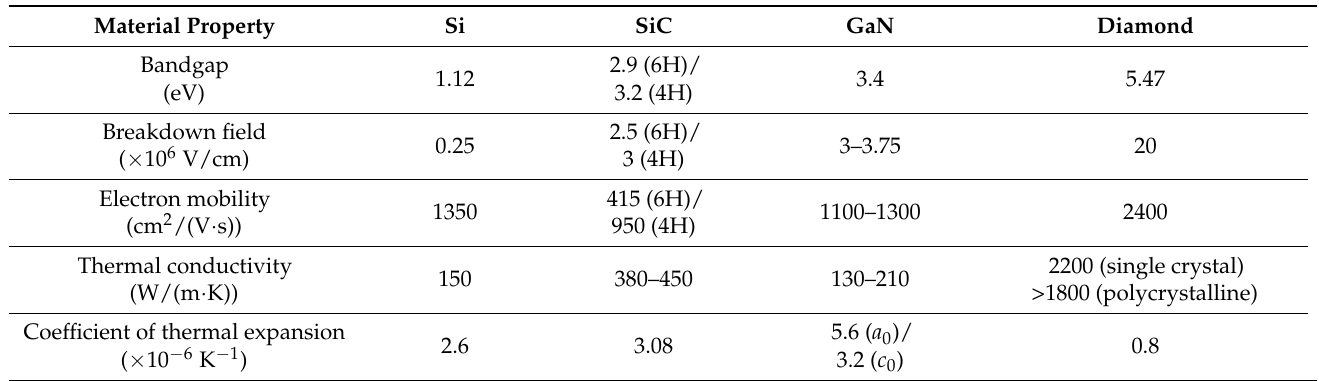
Table 1. Selected properties of relevant semiconductors